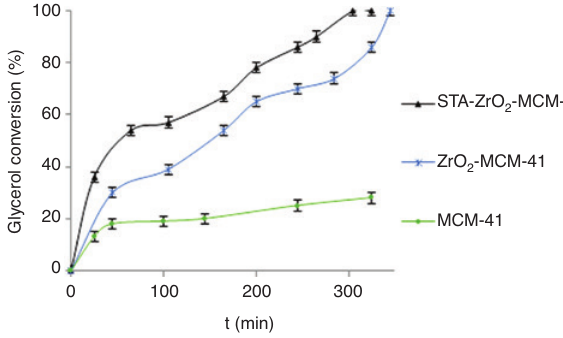
Figure 6: Glycerol conversion of the reactions catalyzed by MCM-41 supported